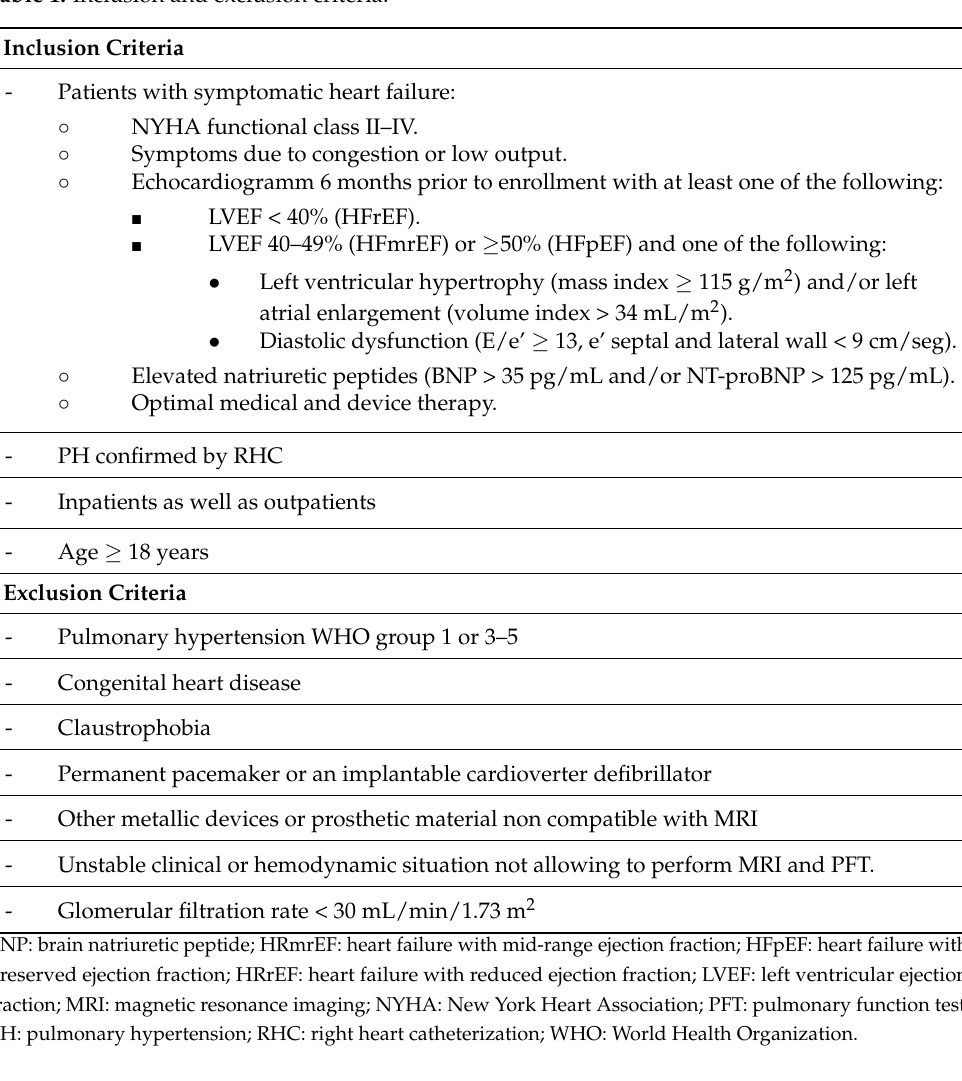
Table 1. Inclusion and exclusion criteria.